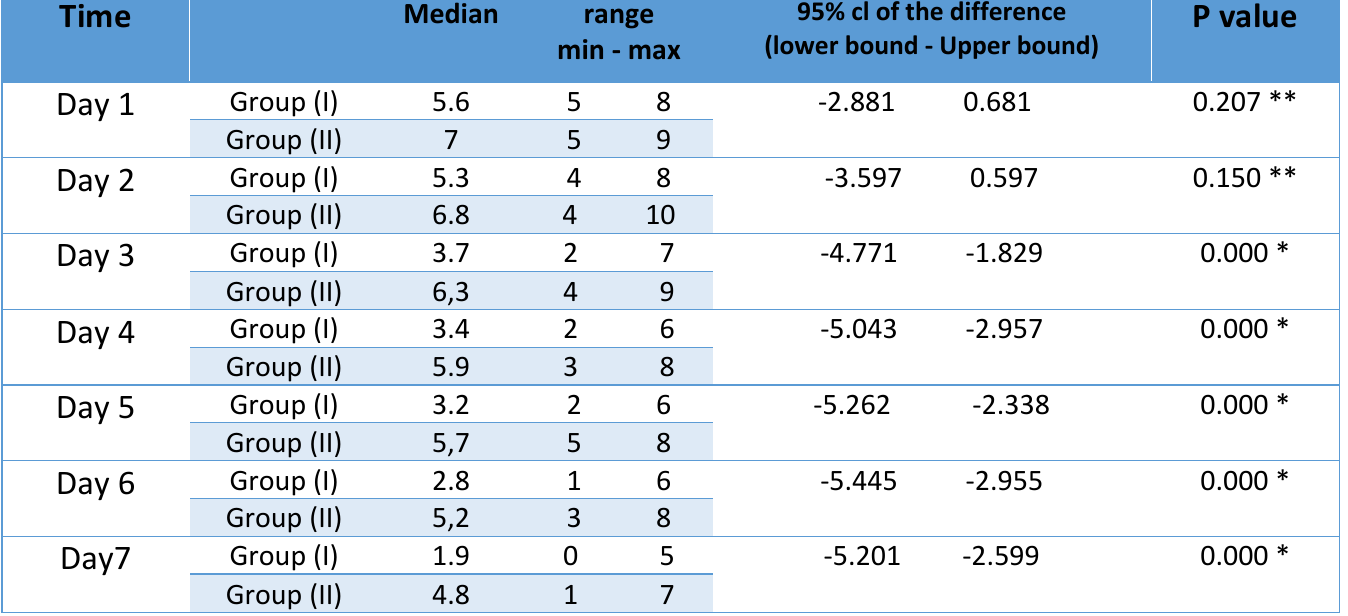
Table 1. Median and range VAS score for postoperative pain from day 1 to day